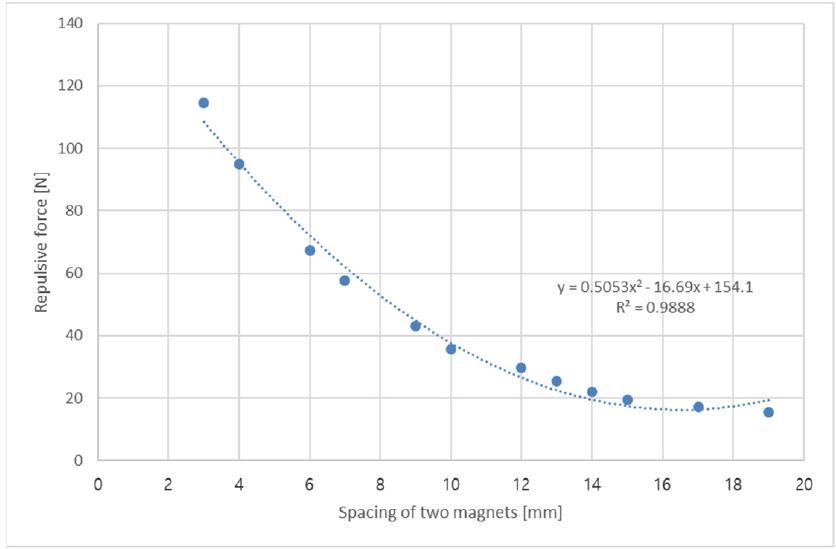
where y is the repulsive force [N] and x is the spacing between the two magnets [mm].